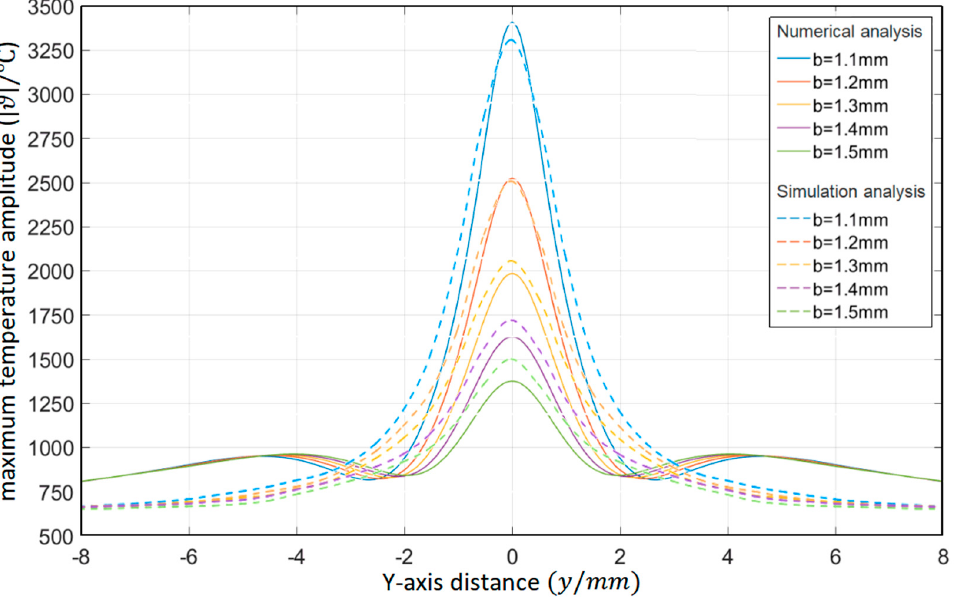
Figure 11. Influence of the non-diffusion incident wave number on the temperature distribution in the Y -axis direction).